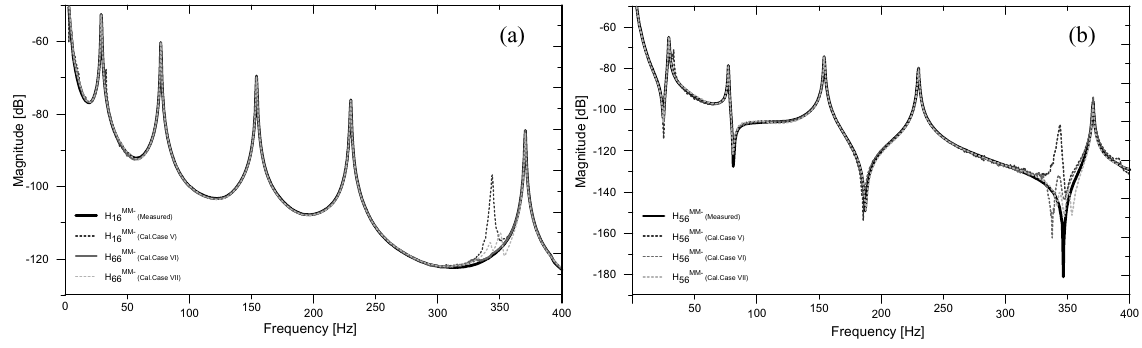
Fig. 19. Measured and estimated receptances (a) H (cid:2) 16 and (b) H (cid:2) 56 , for cases studies V, VI and VII, for the MM- structure.